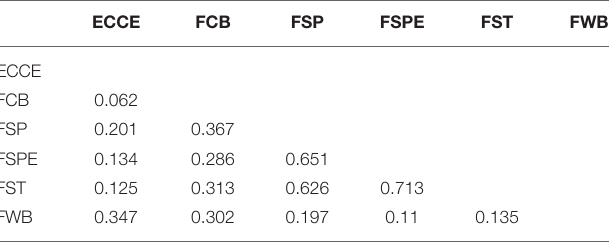
TABLE 4 | Discriminant validity [Heterotrait-monotrait ratio (HTMT)].